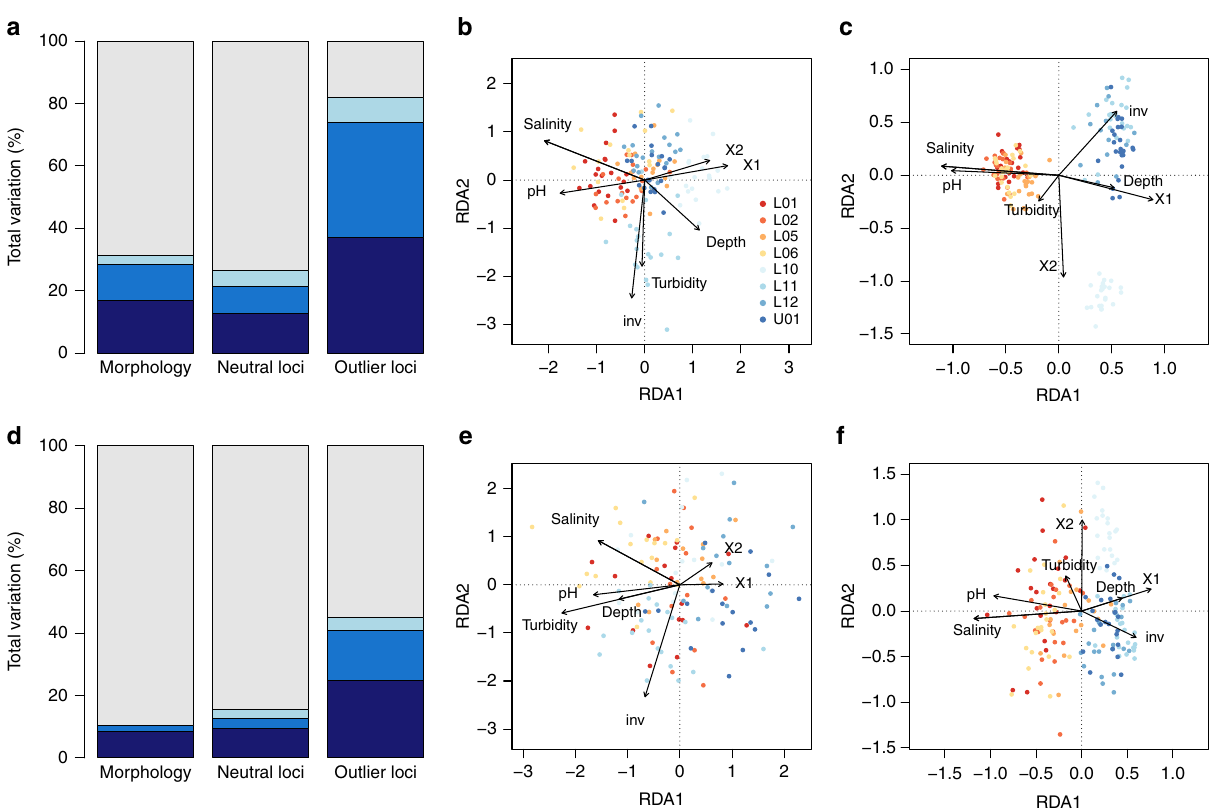
Fig. 3 Redundancy analysis of population divergence in two coexisting stickleback species. Barplots represent the proportion of the total variation in morphology, neutral loci and outlier loci that can be explained by space ( light blue ), environment ( dark blue ) or their interaction ( blue ). Scatterplots show the fi rst (RDA1) vs. the second (RDA2) dimension. Individuals from brackish and freshwater sites are represented by orange-red and blue-shaded dots , respectively. Site characteristics and sample size are listed in Supplementary Table 1. a Variance partitioning of morphological and genomic data in the three-spined stickleback. b Morphological divergence vs. space and environment in the three-spined stickleback. c Genomic divergence at outlier loci vs. space and environment in the three-spined stickleback. d Variance partitioning of morphological and genomic data in the nine-spined stickleback. e Morphological divergence vs. space and environment in the nine-spined stickleback. f Genomic divergence at outlier loci vs. space and environment in the nine-spined